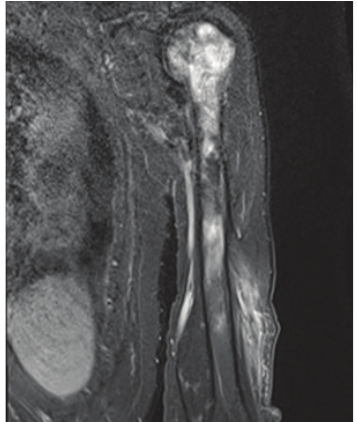
Figure 1: MRI of the left shoulder demonstrates a soft tissue lesion adjacent to the proximal humerus and potential bony